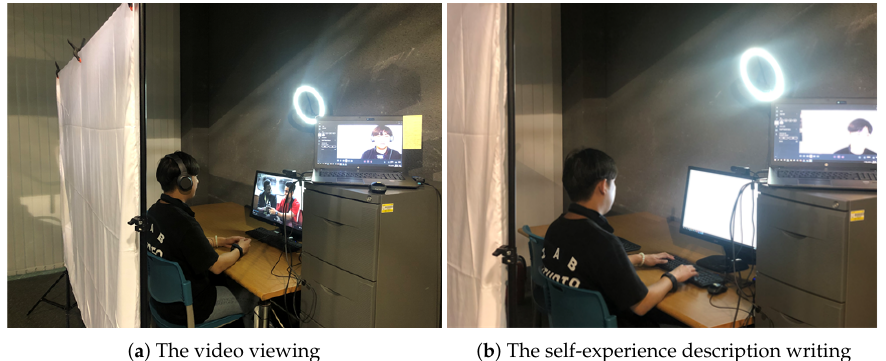
Figure 6. ( a ) The participants’ emotions are induced through video viewing. ( b ) The participants describe their own experiences related to the emotions